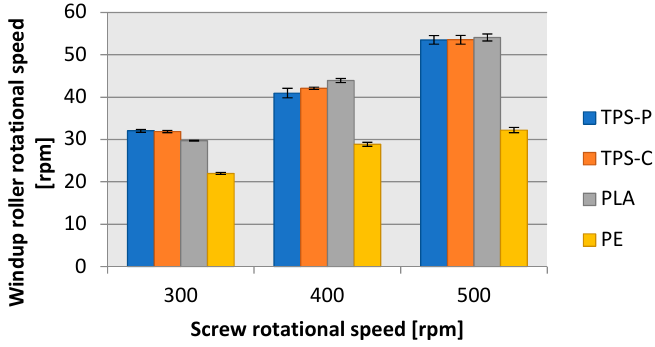
Figure 9. Relationship between the rotational speed of the receiving rollers and the rotational speed of the extruder screw.